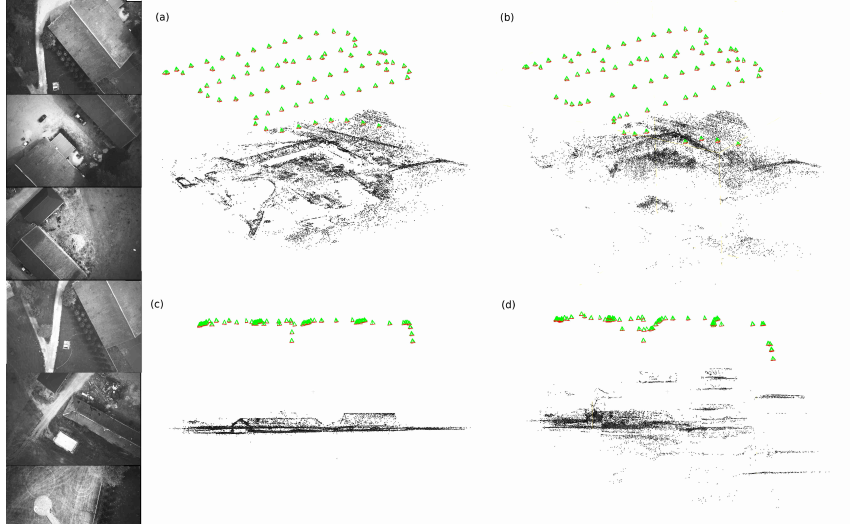
Figure 5. Left: excerpt from the UAV dataset. Right: (a) and (c) is the ground truth in oblique and side view; (b) and (d) is the equivalent SfmInit result. Note the erroneous initialisation of SfmInit in (b) and (d) where exclusively pairwise constraints are used.